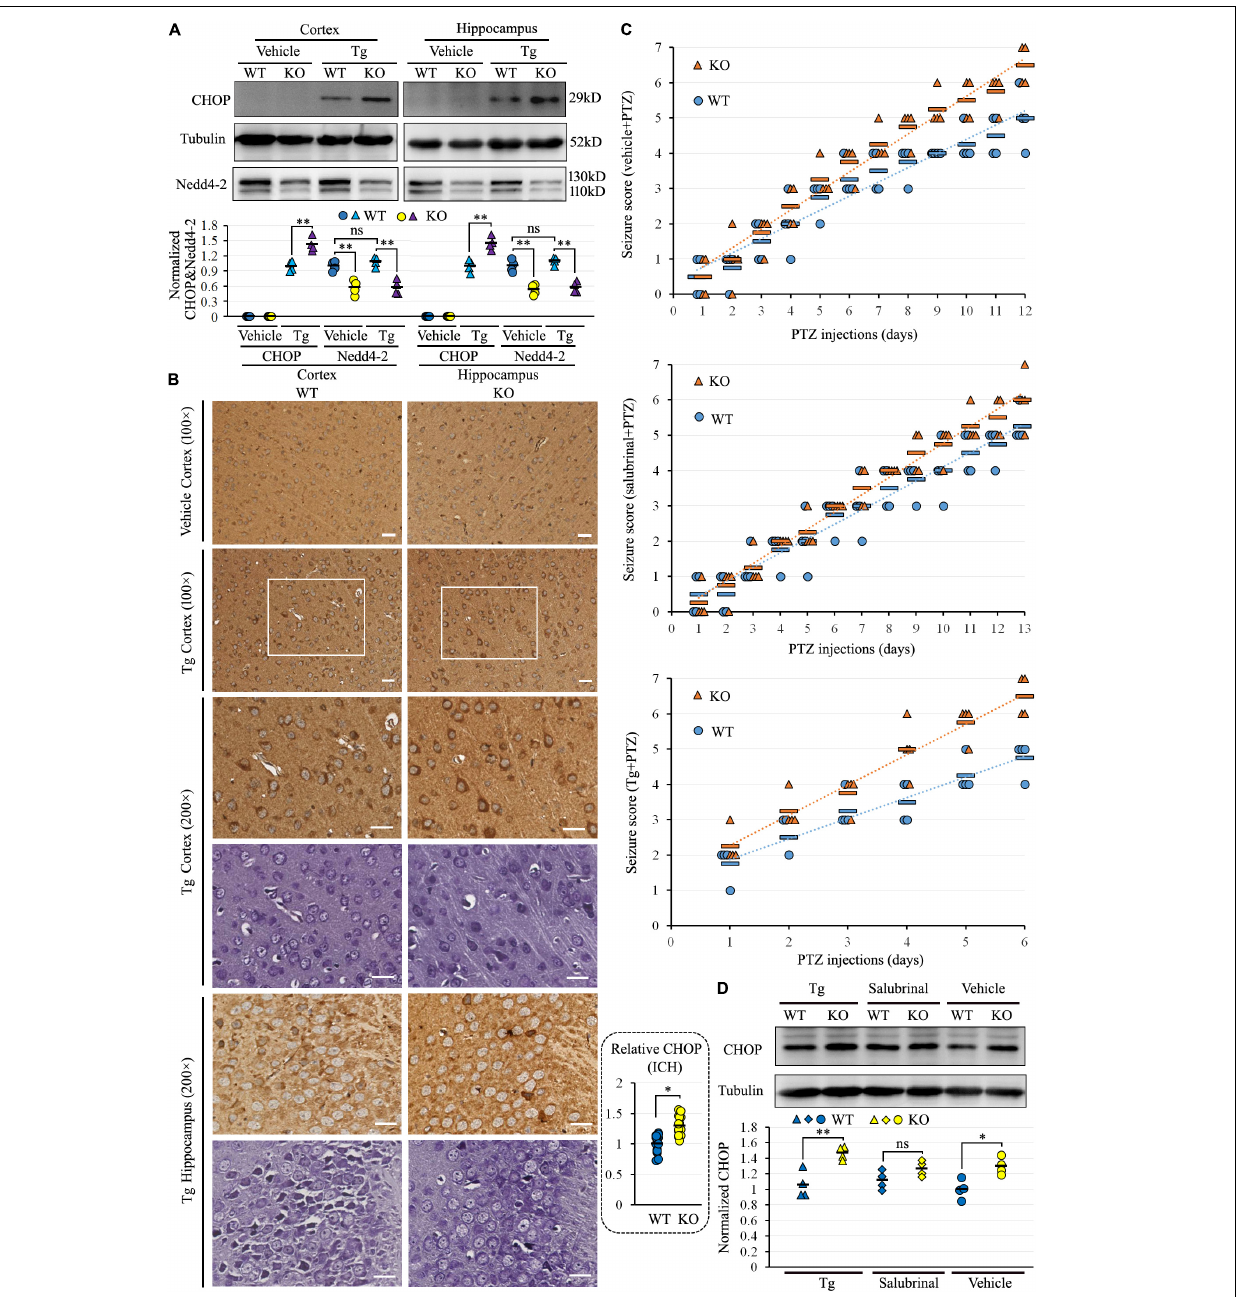
FIGURE 1 | Nedd4-2 + / − (KO) mice were vulnerable to ER stress and pentylenetetrazole (PTZ)-induced seizures. (A) Western blot analysis of Nedd4-2 and the ER stress marker of CHOP in KO and wild-type (WT) mice ( n = 4 in each group) with ER stress inducer of Tg (2 mg/kg) treatment for 6 h. The CHOP in the vehicle-treated group was undetectable and not analyzed. ns, not significant, ** P < 0.01 analyzed with 2-way ANOVA for Nedd4-2 and post hoc Tukey for CHOP. (B) Immunohistochemistry (ICH) of CHOP and Nissl staining on serial brain slices (cortex and hippocampus CA3 region) of mice with acute Tg induction. The CHOP signals (brown) were stronger in KO than WT mice, and co-localized to the Nissl staining (purple) signals. Scale bar: 20 µ m. ∗ P < 0.05 by Student’s t -test for the quantification (16 areas of 200 × 200 µ m 2 ) by ImageJ. (C) Seizure scores were evaluated according to the Racine scale in mice with pretreatment of 1 mg/kg Tg, 2 mg/kg ER stress inhibitor of salubrinal, or vehicle control for 1 h, followed by PTZ (35 mg/kg) induction ( n = 8 in each group). Tg treatment significantly elevated the seizure scores in 6 days of treatment (KO mice: P = 0.037 in Tg vs. Vehicle, P = 0.008 in Tg vs. salubrinal; WT mice: P = 0.045 in Tg vs. Vehicle, P = 0.020 in Tg vs. salubrinal analyzed using Kruskal–Wallis tests). Relatively higher seizure scores could be observed in KO mice over WT mice within each pre-treatment group, with no statistical significance analyzed by the Mann–Whitney U test. (D) Western blotting analysis of the CHOP expression in mouse brains at the end of chronic induction. The CHOP levels were higher in KO than WT mice in all three groups, with the most significant disparity in the Tg pretreatment group ( n = 4 in each group). ns, not significant, ∗ P < 0.05, ∗∗ P < 0.01 compared with WT controls by post hoc Tukey analysis.